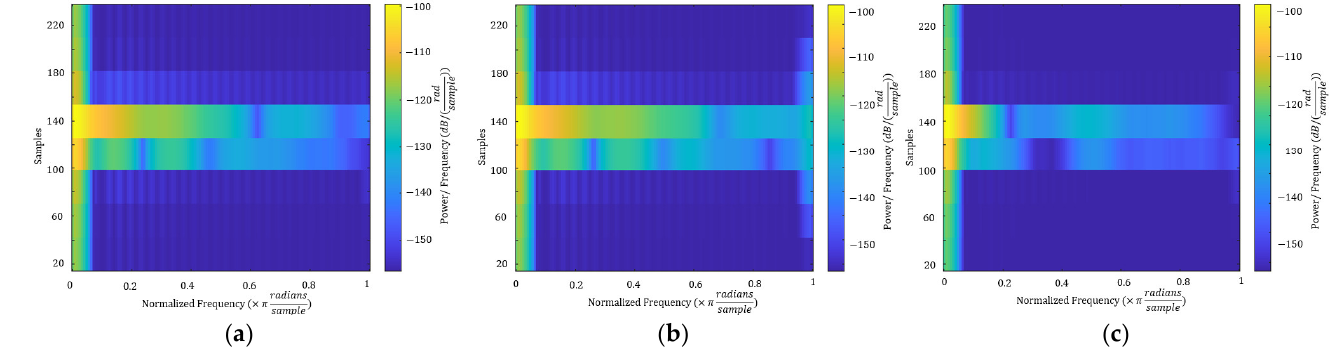
Figure 8. A comparison of the three enveloped reflected signals in the spectrogram is made when U1 and U2 pronounce the vowel “a”: ( a ) Comparing the same sample of U1; ( b ) Comparing two samples of the same passphrase of U1; ( c ) Comparing the same passphrase of U1 and U2.